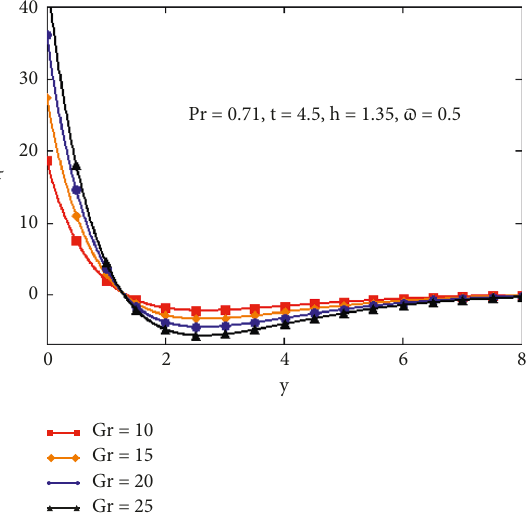
Figure 8: Skin friction profile for different values of